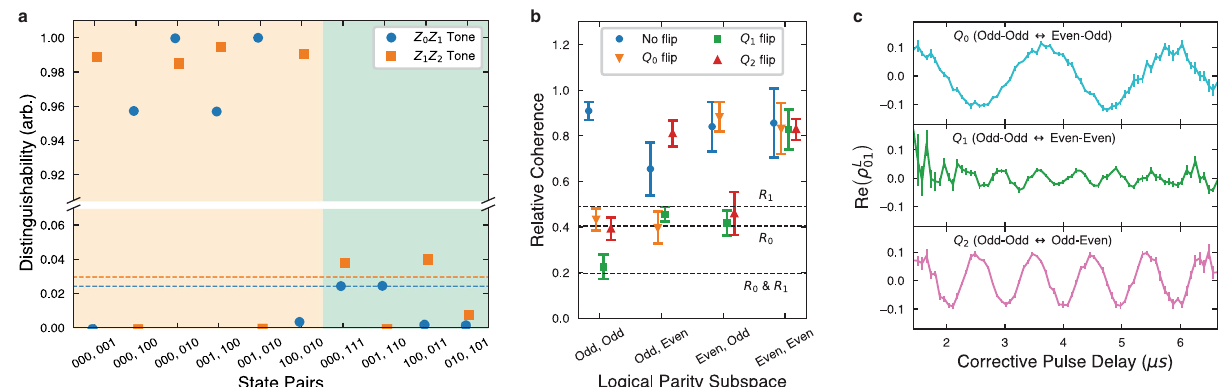
Fig. 4 Preservation of quantum coherence. a Distinguishability of various state pairs in steady state readout for each measurement tone. Pairs of states in the yellow region differ in one or both of their parities. Pairs of states in the green region share their parities. Dashed lines indicate theoretically predicted distinguishability of the even eigenstates. b Relative logical coherence after preparing a logical þ X L 0 parity measurement tones without feedback, and fl ipping one of the qubits. Coherences are normalized to results from the same procedure without the measurement tones applied. Error bars are statistical uncertainty from repeated runs of the measurement. Dashed lines indicate predicted relative dephasing due to an odd to even parity fl ip on R 0 , R 1 , or both. c Sample coherences from preparing a logical þ X L an error pulse, and letting the controller correct the error. Coherences are reconstructed by time bins set by the time it takes to correct the error with error bars representing statistical uncertainty. Oscillations due to static ZZ coupling are